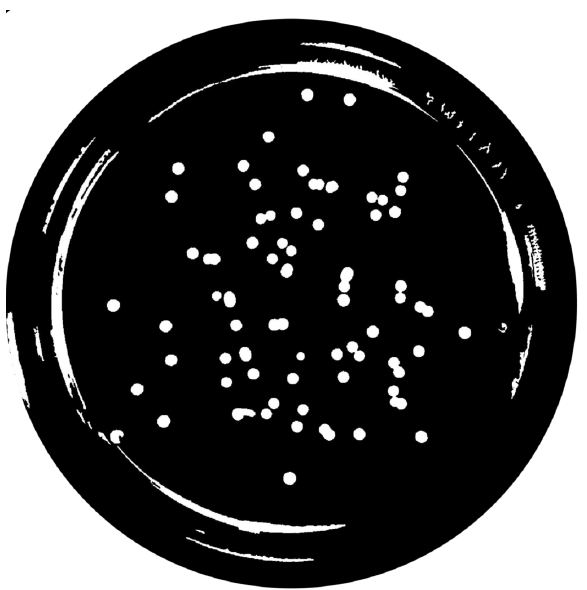
Figure 10. Elimination of small objects with less than 250 pixels by area-opening